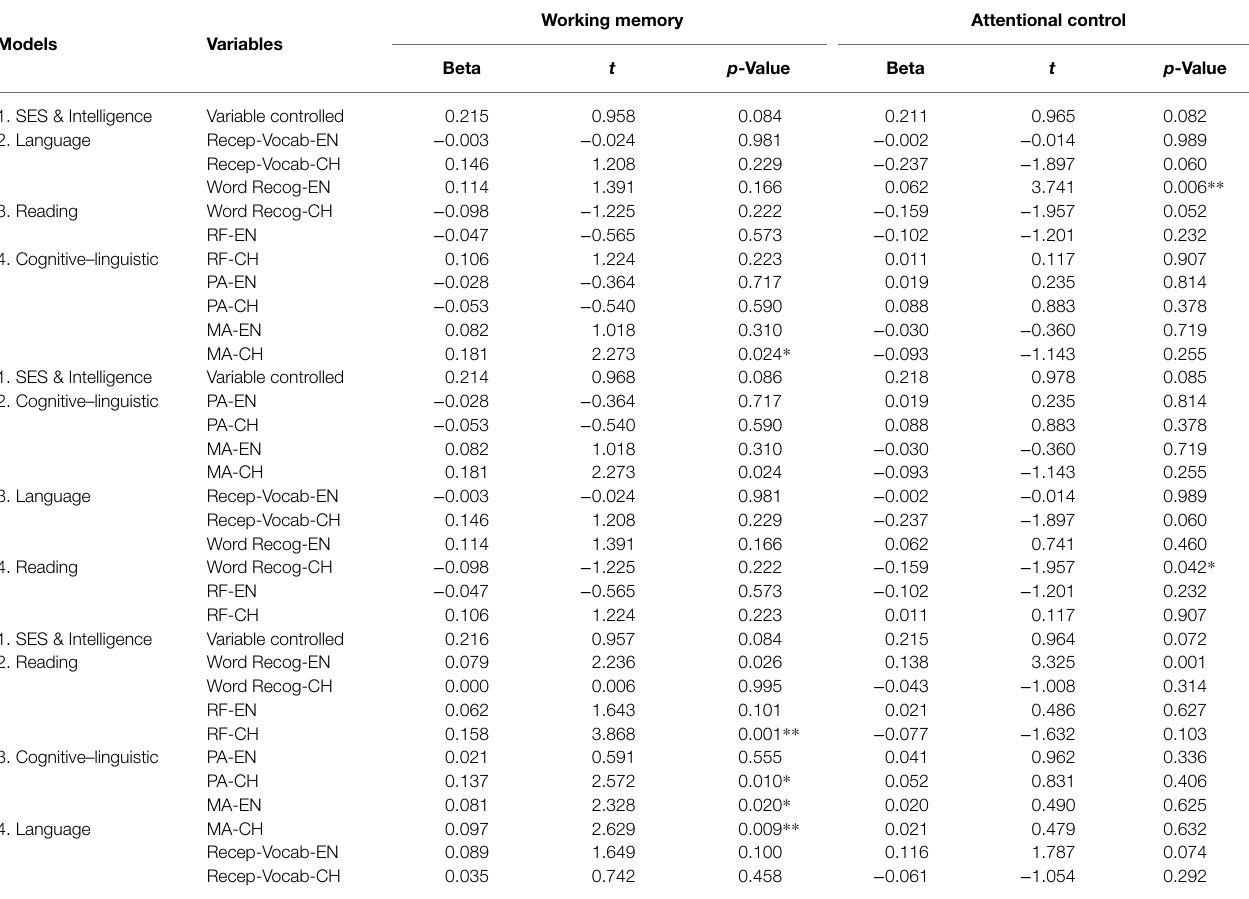
TABLE 8 | The contribution of SES, intelligence, reading, and linguistic measures to cognitive skills in grade 6—hierarchical regression summary table.